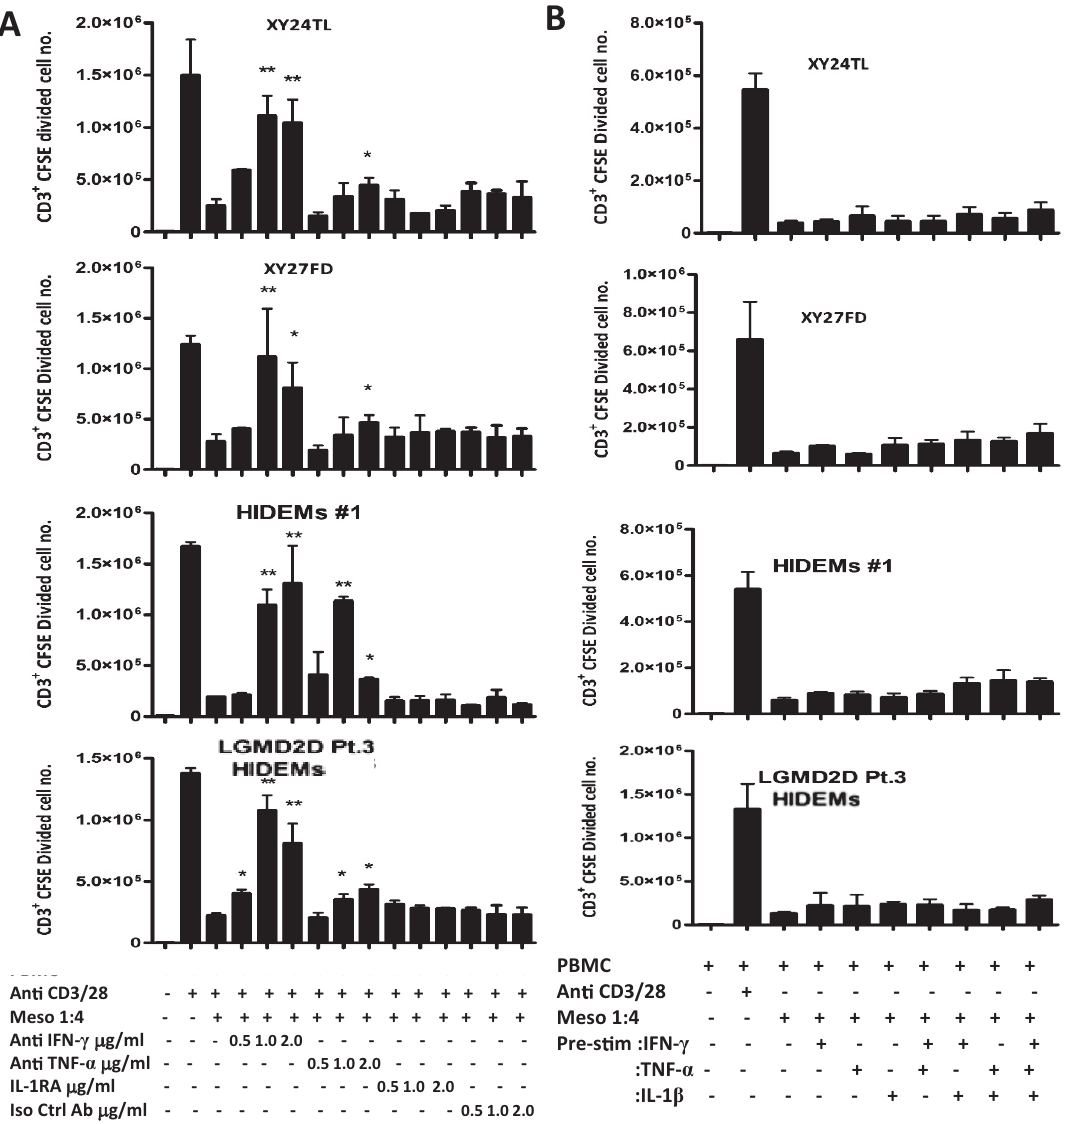
Figure 4. IFN- γ and TNF- α play important roles in HIDEM and mesoangioblast suppression of T cell proliferation. CFSE-labelled PBMCs were stimulated with anti-CD3/CD28 beads in the presence of HIDEMs/mesoangioblasts (1:4) and neutralising antibodies against IFN- γ and TNF- α or irrelevant isotype control antibody (0.5, 1.0 and 2.0 µg/ml) or recombinant IL-1RA (0.5, 1.0 and 2.0 µg/ml). Cells were harvested on day 6 and stained with anti-CD3 and 7AAD. After gating on CD3 + 7AAD - the number of CFSE diluting cells were enumerated using counting beads. Data are represented as mean CD3 + CFSE diluted cell number +/- SE. *p<0.05, **p<0.01 ( A ). HIDEMs/mesoangioblasts were left untreated or were stimulated with IFN- γ , TNF- α or IL-1 β (20ng/ml) for 24h before setting up co-cultures with CFSE labelled PBMCs. As a positive control, PBMCs were stimulated with anti CD3/CD28 beads. After 6 days cells were harvested and surface stained for CD3 and 7AAD before analysis of CFSE dilution. CD3 + CFSE diluted cell numbers were calculated using counting beads as before ( B ). Experiments were carried out in duplicates.